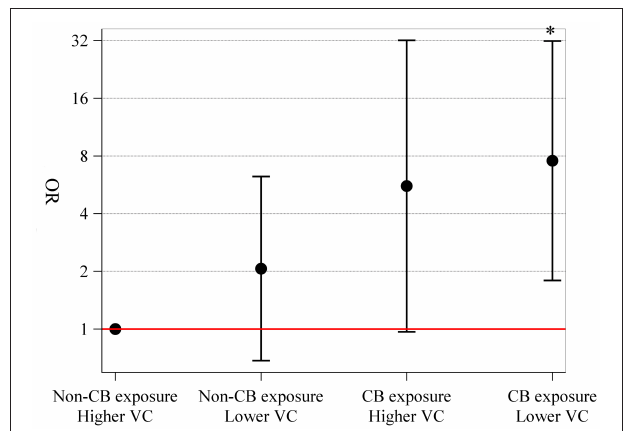
FIGURE 3 | Joint effects of CB exposure and vitamin C intake on small airway dysfunction. We stratified our subjects into four groups: non-CB exposure and higher vitamin C intake ( ≥ 119mg day − 1 ) (reference), non-CB exposure and lower vitamin C intake ( < 119mg day − 1 ), CB exposure and higher vitamin C intake, and CB exposure and lower vitamin C intake, with the number of people in each group being 69, 37, 18, and 50, respectively. Joint effects were explored using logistic regression model with adjustment for age, sex, body mass index, education level, family income level, smoking status, packyears, and drinking status. CB, carbon black; VC, vitamin